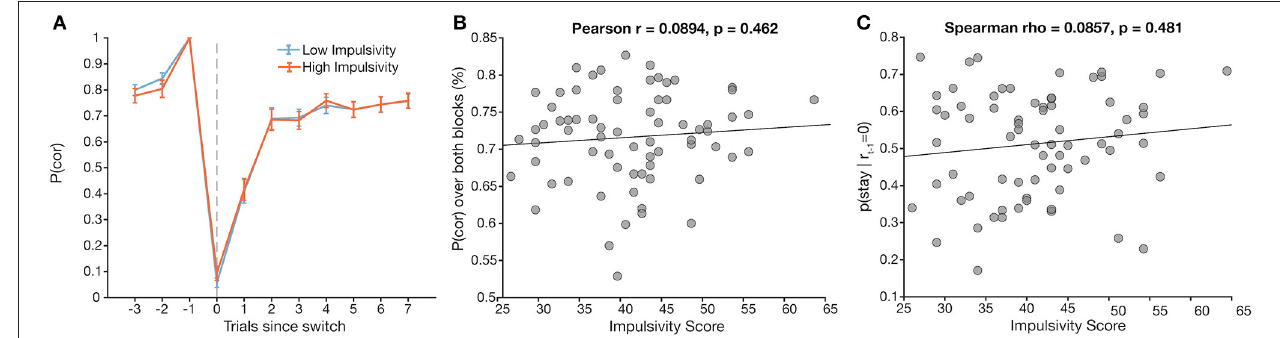
FIGURE 3 | Total impulsivity score does not relate to a priori behavioral measures. (A) Task performance [ p ( cor )] around a switch trial plotted across low (blue) and high (orange) impulsivity groups (assigned via median split). (B) Total impulsivity score vs. overall task performance ( r = 0.09, p = 0.46). (C) Total impulsivity score vs. probability of staying after an unrewarded trial ( ρ = 0.09, p = 0.47).